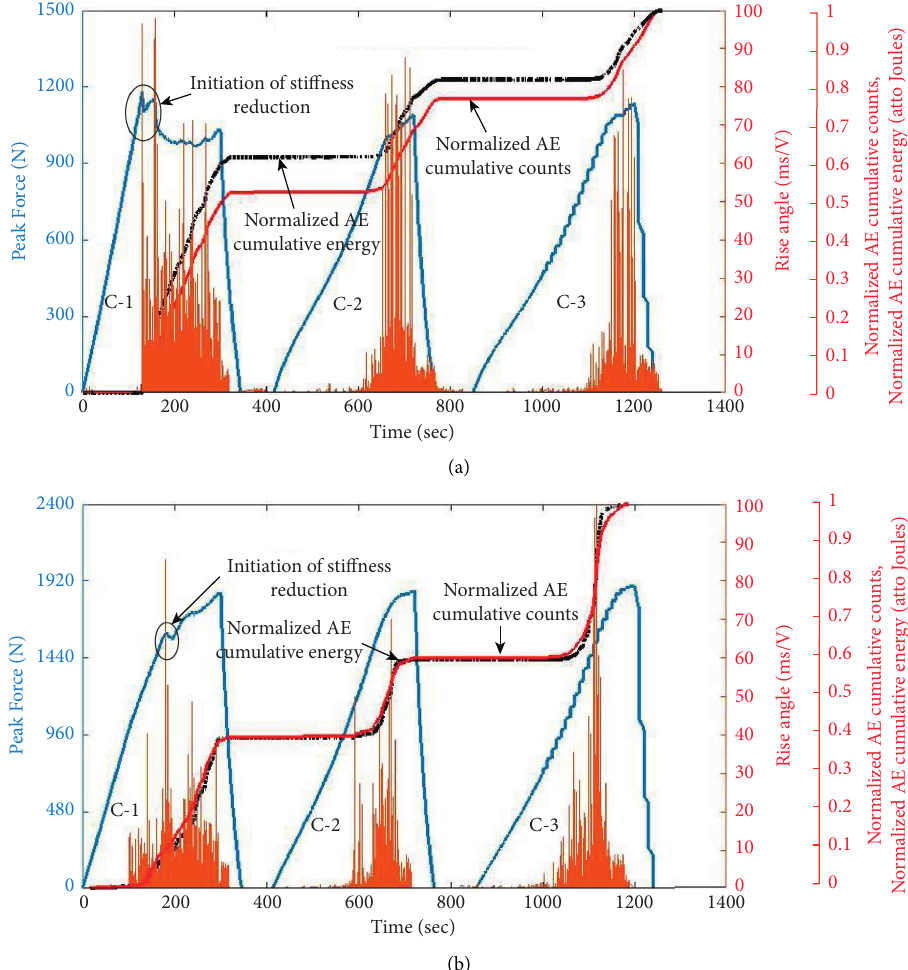
Figure 8: Representation of AE activity with damage progression during cyclic indentation: (a) bidirectional glass/epoxy and (b) chopped glass/epoxy